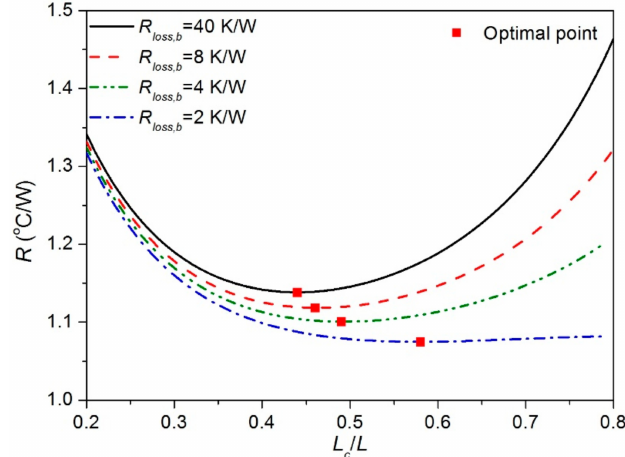
Figure 9. Thermal resistances for various heat losses through the back of the heat sink ( Q = 0.2 m 3 / min, w c = 7 mm, L h / L =